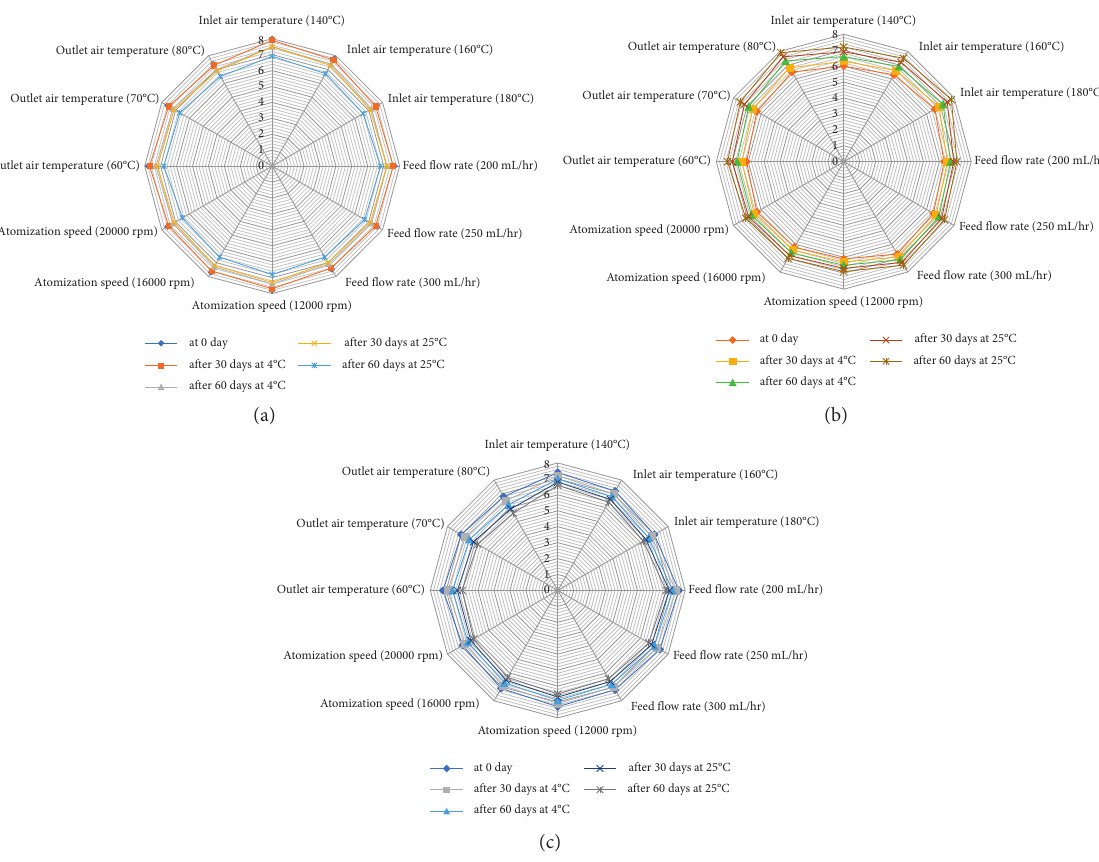
Figure 4: Sensoric evaluation of spray-dried flaxseed oil samples at different temperatures and storage intervals. (a) Color score. (b) Off- flavor score. (c) Overall acceptability